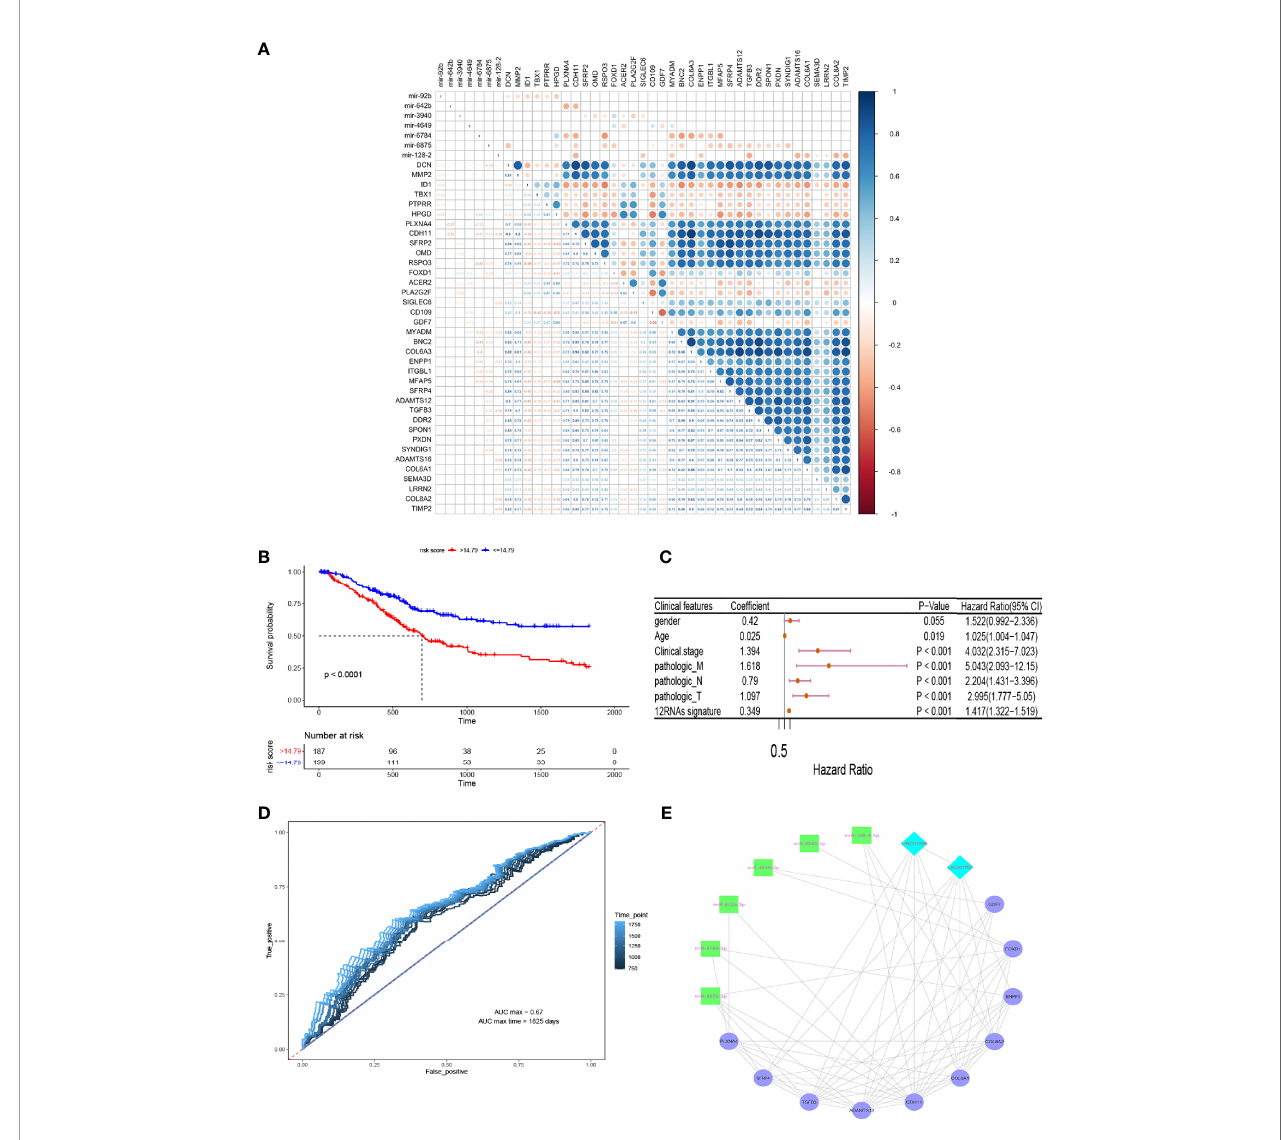
FIGURE 5 | Prediction of miRNA-mRNA pairs and RNA-based signature prognostic models. (A) Pearson correlation analysis to establish a correlation coef fi cient matrix. (B) A RNA signature model for survival risk analysis. (C) univariate Cox regression analysis exhibited that the twelve-RNA signature was evidently positively correlated with overall survival of BCa patients. (D) 2 to 5 years dependent ROC curves. (E) Core lncRNA-miRNA-mRNA triple-regulatory co-expression